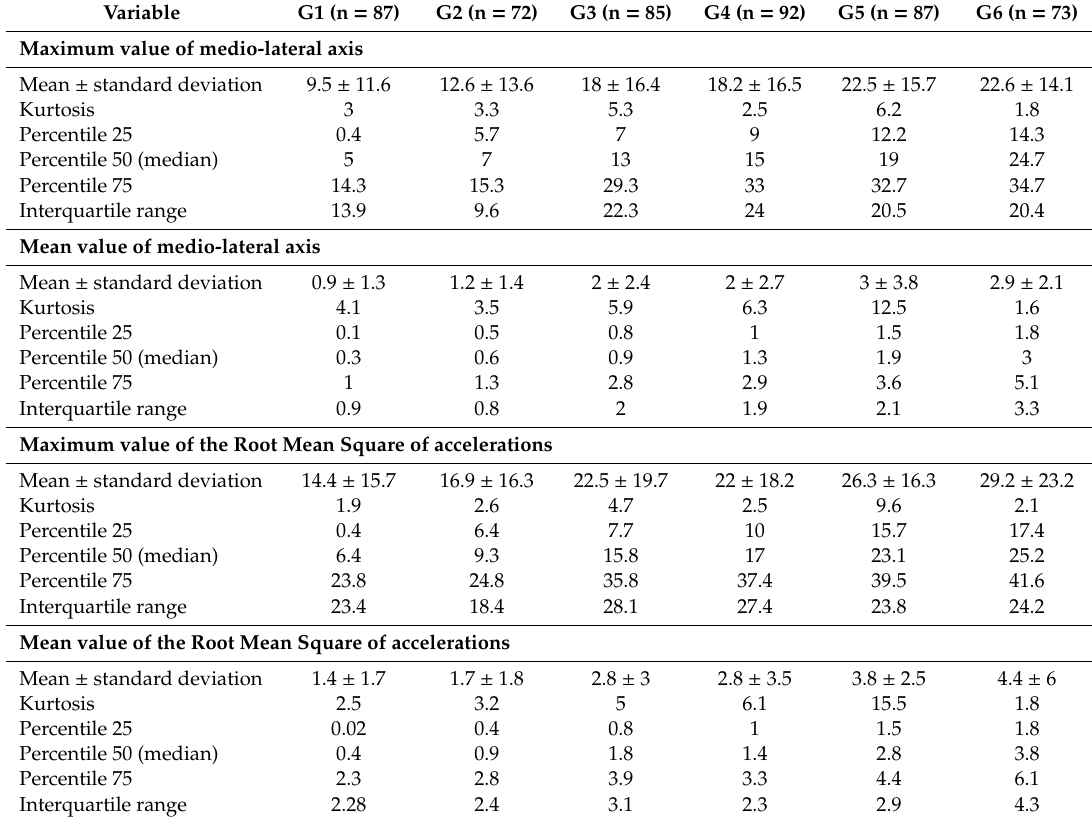
Table 4. Percentiles and descriptive statistics for the monopodal balance test on unstable surface